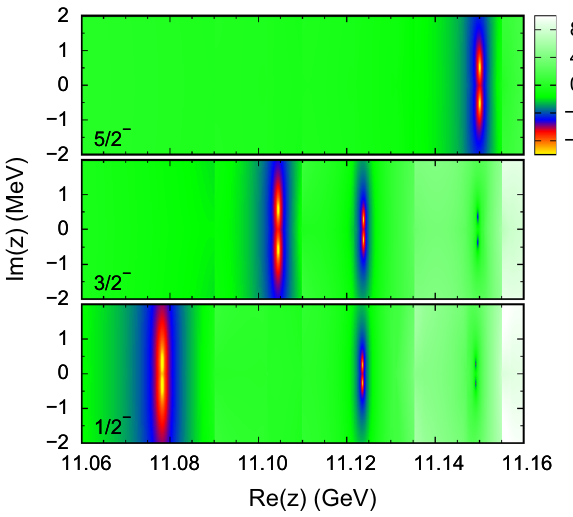
Fig. 3 The log | 1 − V ( z ) G 0 ( z ) | with the variation of z for coupled- ( ∗ ) B ( ∗ ) − Λ b B ( ∗ ) interaction with J P = 1 / 2 − , 3 / 2 − and channel Σ b 5 / 2 − at α = 1 . 5. The color means the value of log | 1 − V ( z ) G 0 ( z ) | as shown in the color